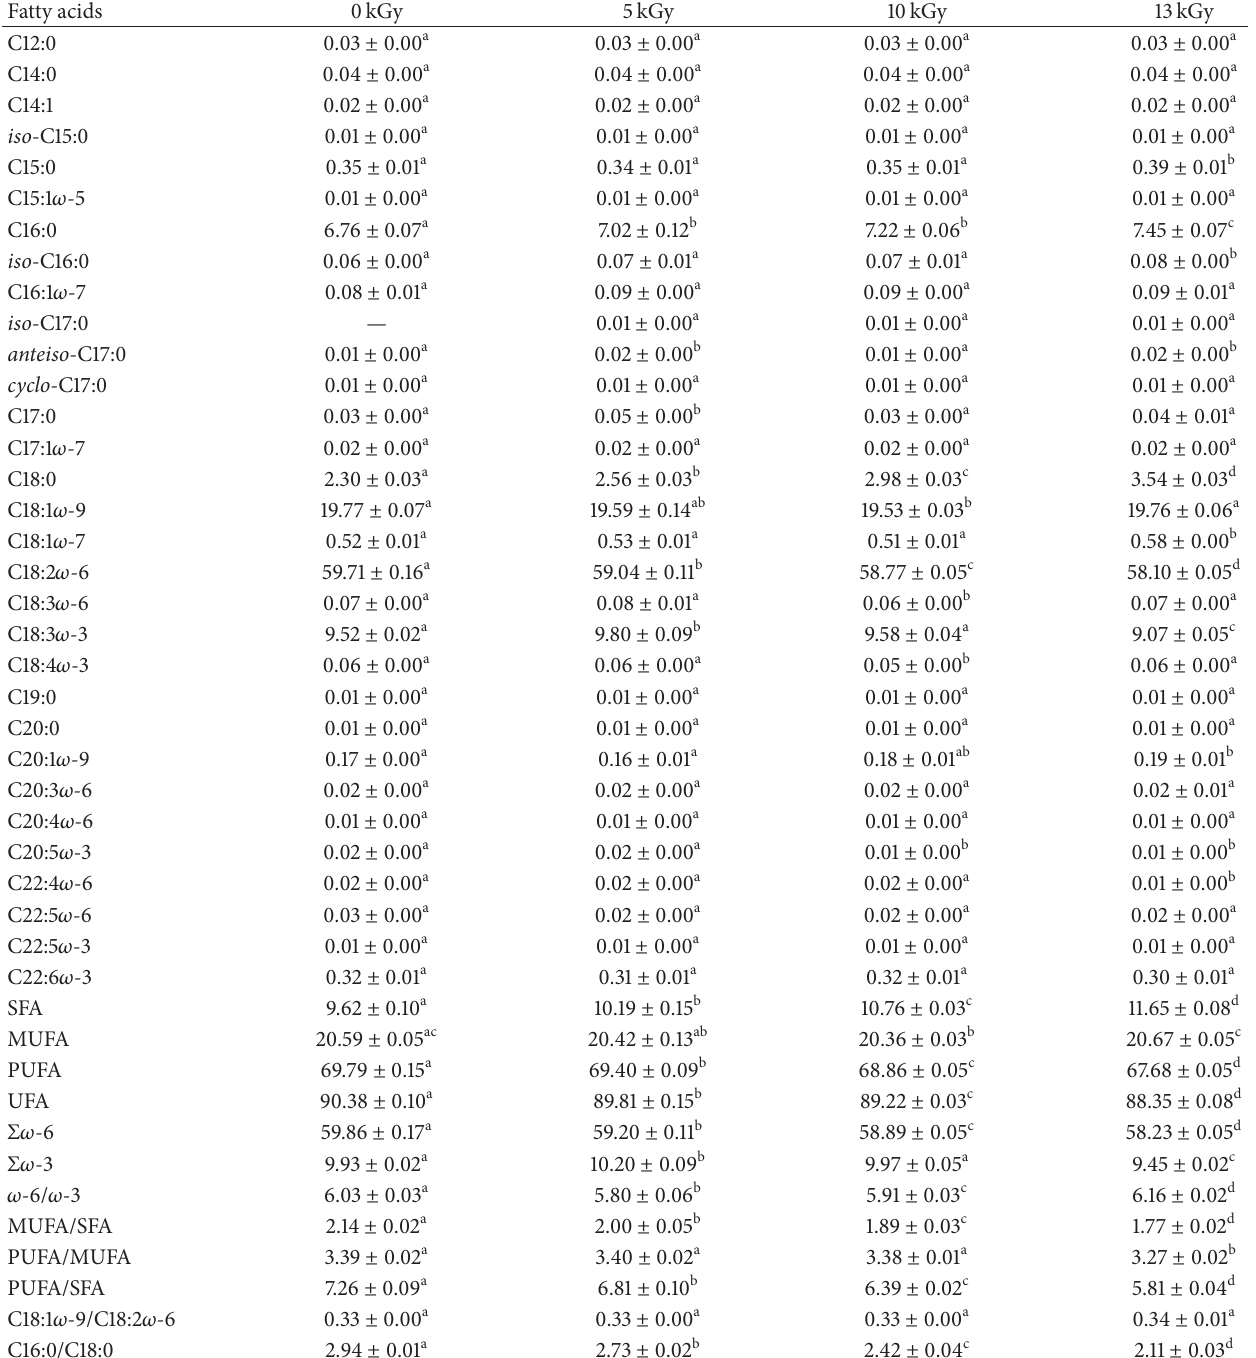
Table 3: Fatty acids composition % of (Total Fatty Acids) TFA in total lipids of non-irradiated and irradiated walnuts packaged in modified